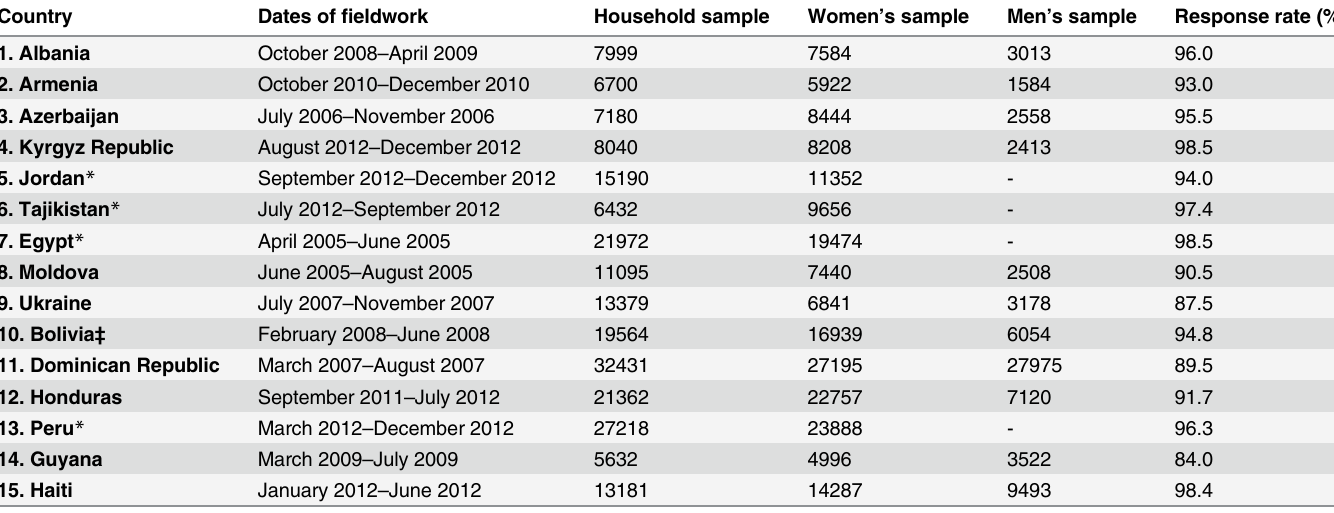
Table 1. Survey characteristics, sample sizes and responses of Demographic and Health Surveys.